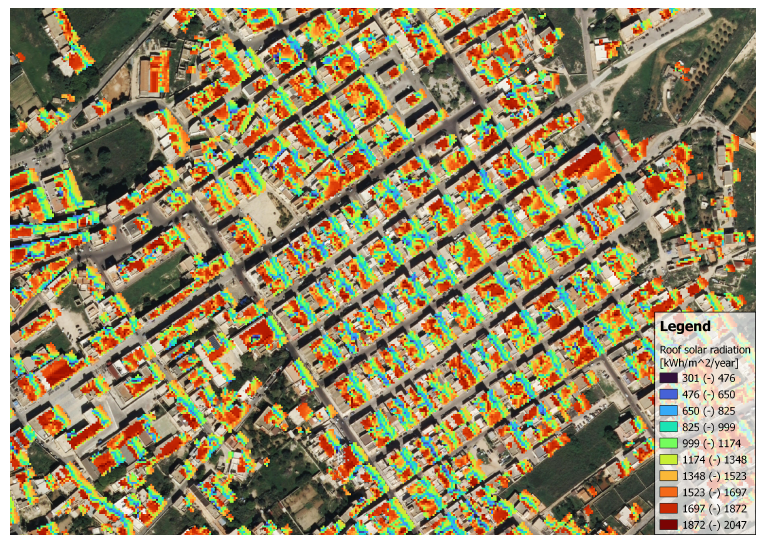
Figure 14. Total irradiance on ground and